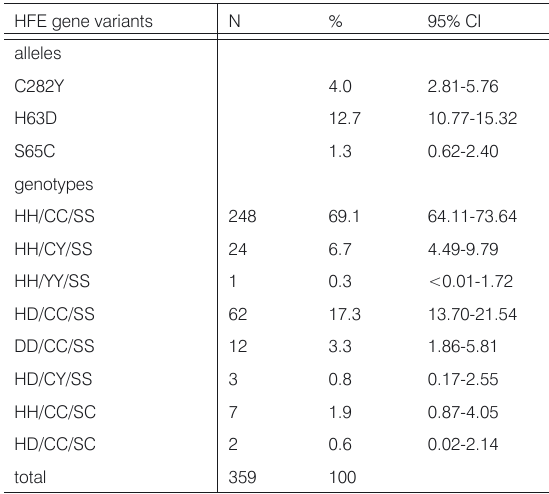
Table 1. Frequencies of HFE alleles and genotypes. N - number of individuals, CI - confidence interval, names of genotypes are formed of respective abbreviated amino